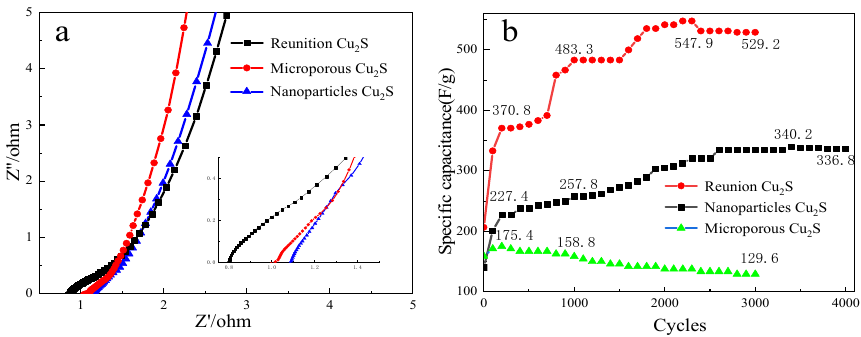
Figure 11. Different impedance curves of ( a ) three different morphologies of Cu 2 S; different cyclic stability of ( b ) three different morphologies of Cu 2 S.